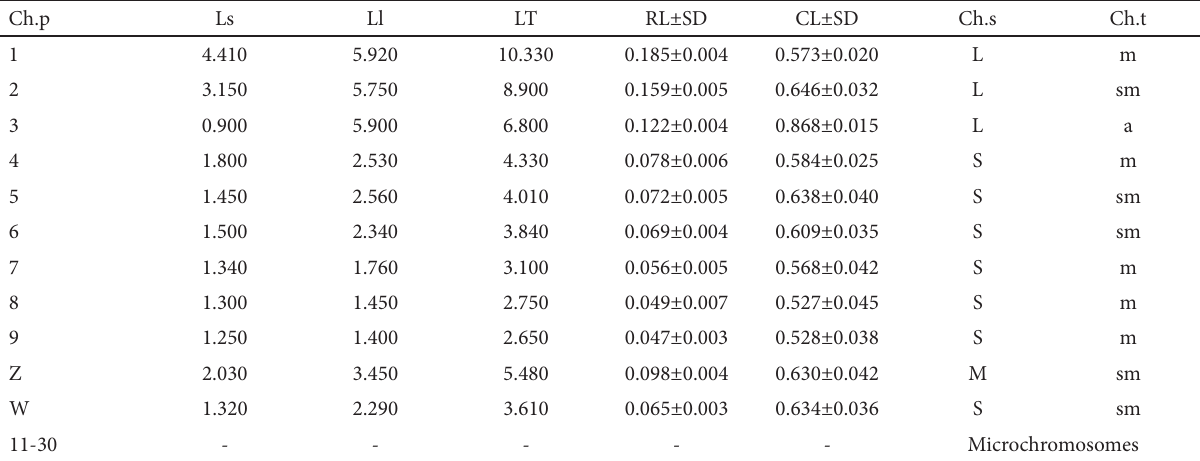
Table 2. Mean length of short arm chromosome (Ls), long arm chromosome (Ll), total arm chromosome (LT), relative length (RL), cen- tromeric index (CI), and standard deviation (SD) of RL, CI from 20 metaphase cells of male and female little grebe ( Tachybaptus ruficollis ), 2 n =60. Ch.p